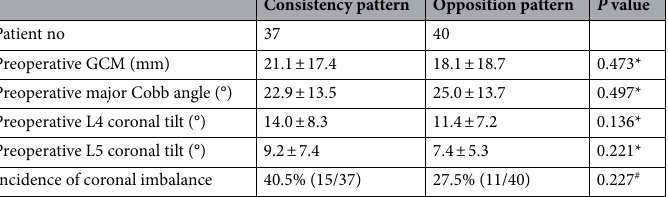
Table 2. Comparison of preoperative radiographic parameters between two groups. GCM global coronal malalignment. *Independent t test. # Chi-square test.